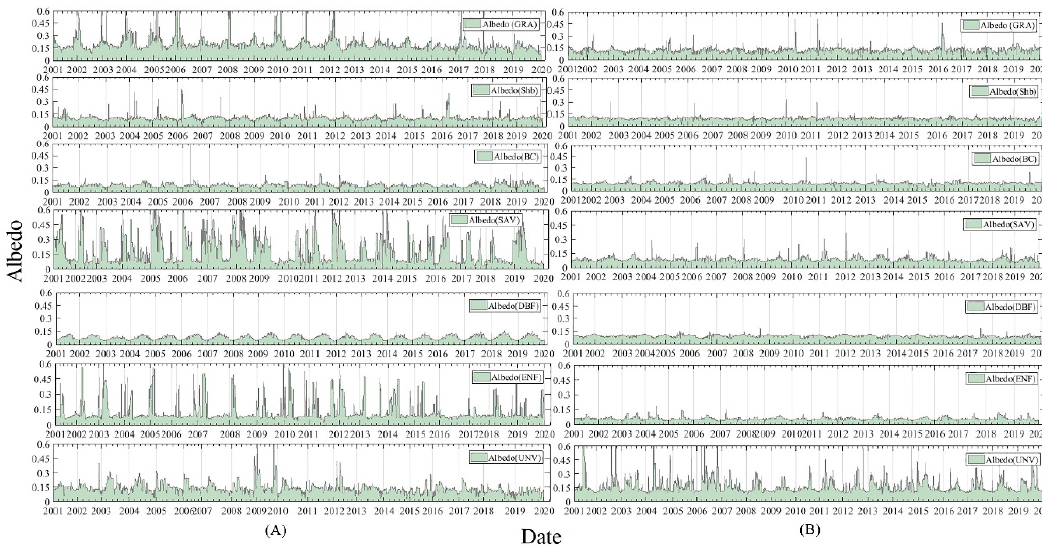
Figure 8. The albedo variation over different land cover types at the sites, with the mean slope of 35 degrees from 2001 to 2019. ( A ). The sites at the south-facing slope. ( B ) The sites at the north-facing slope.